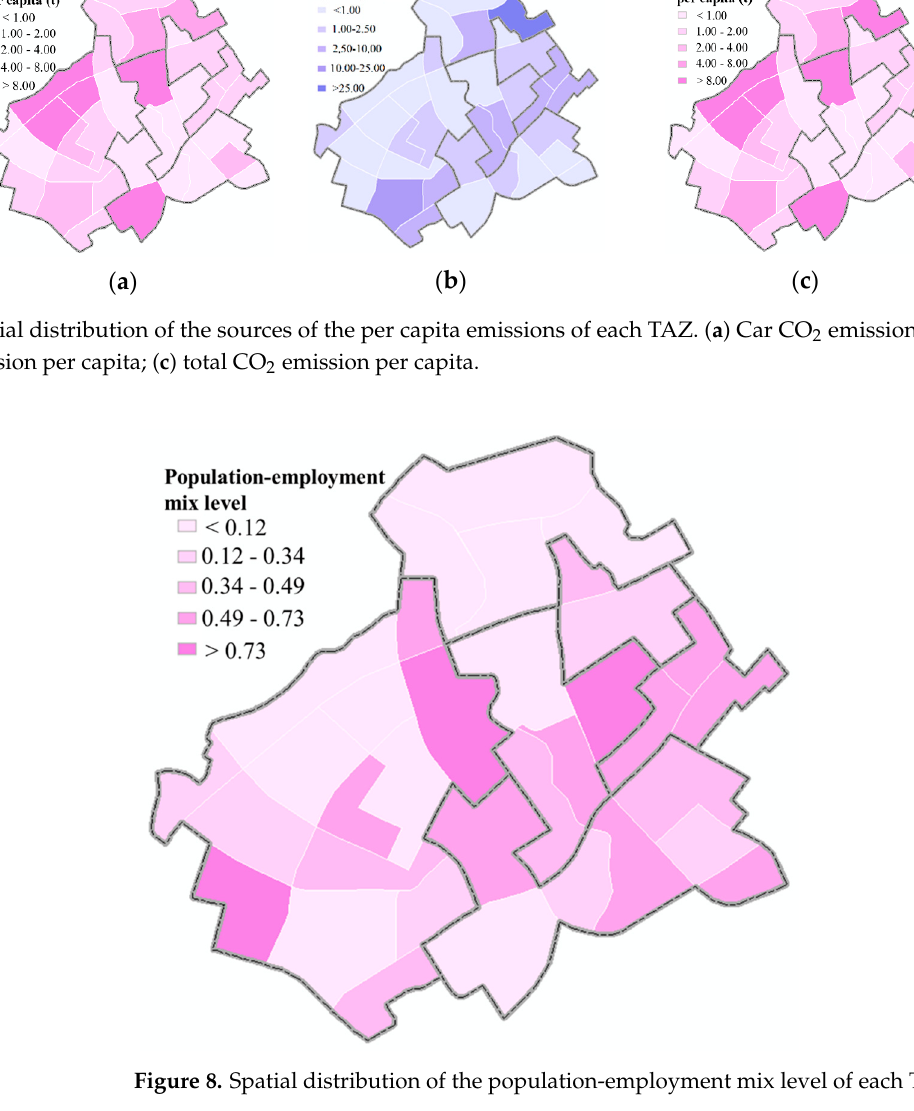
( c ) Figure 6. Spatial distribution of the passenger transport emissions of each TAZ. ( a ) Car CO 2 emissions; ( b ) bus CO 2 emissions; ( c ) total CO 2 emissions. The spatial distribution patterns of the sources of the per capita emissions of each TAZ are shown in Figure 7. People traveling from TAZs with lower values of per capita emissions show they have low emissions on their trips. Total emissions per capita in the eastern downtown center are lower than those in the north and southwest TAZs because